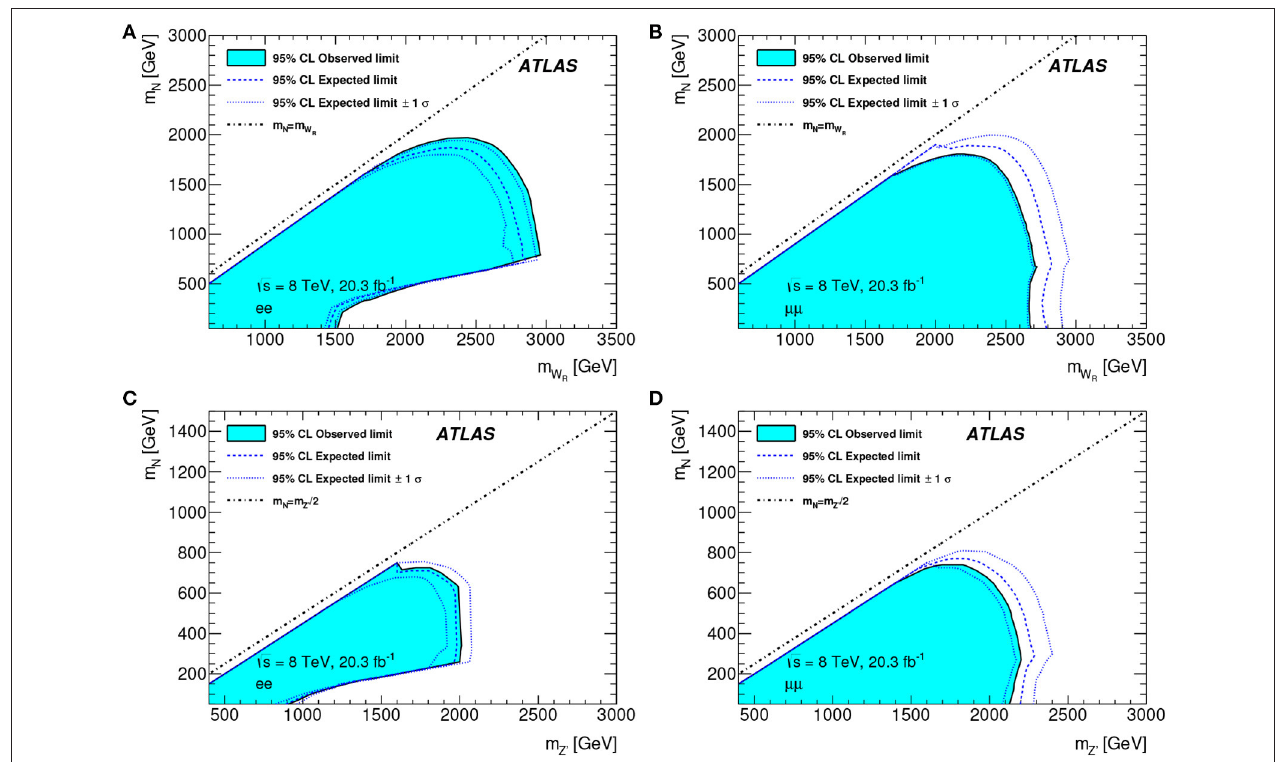
W R (Top) and V Z R (Bottom) production in the (L) 8 for V = = =